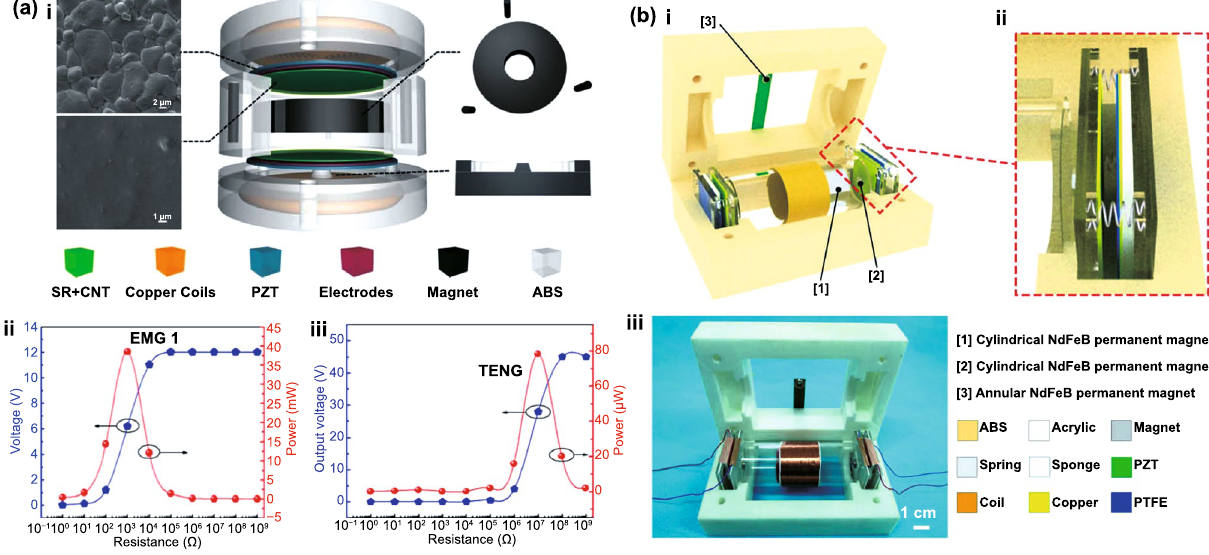
Fig. 18 a (i) Triboelectric-piezoelectric-electromagnetic hybrid nanogenerator structure developed by He et al. and SEM images of the PZT and the CNT-doped silicone layers. Dependence of the output voltage and output power of the (ii) EMG and (iii) TENG on the external load resistance. Reproduced with permission from Ref. [85]. Copyright 2017, Elsevier Ltd. All rights reserved. b Structural design of the integrated triboelectric–electromagnetic–piezoelectric hybrid energy harvester designed by Ma et al. (i) Schematic diagram of the hybrid energy harvester. (ii) Enlarged illustration of the TENG structure. (iii) Photograph of the hybrid energy harvester. Reproduced with permission from Ref. [86]. Copyright 2019, WILEY ‐ VCH Verlag GmbH & Co. KGaA, Weinheim. (Color figure